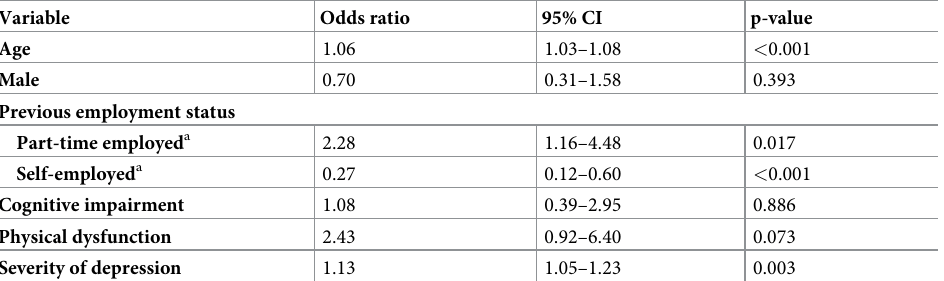
Table 2. Multivariable analysis of factors associated with unemployed status 12 months after intensive care unit